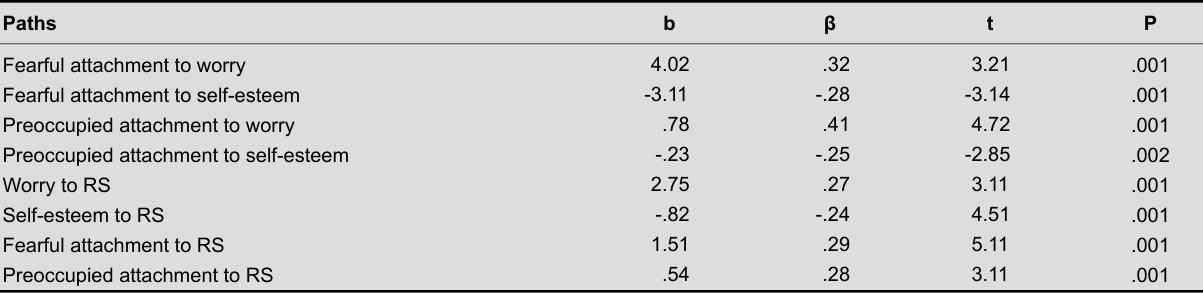
Standardized Direct Effects of Proposed Variables on Rejection